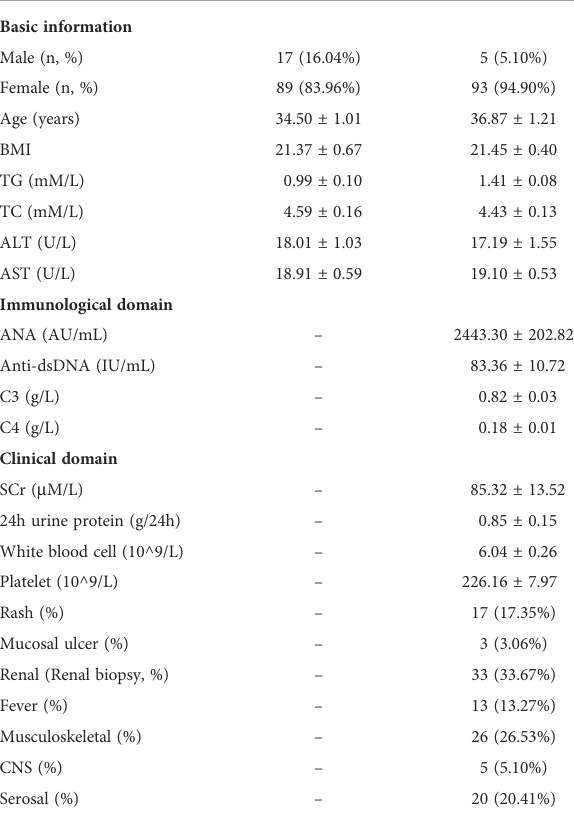
TABLE 1 Clinical characteristics of the SLE patients at the time of recruitment. Healthy controls (n=106) SLE